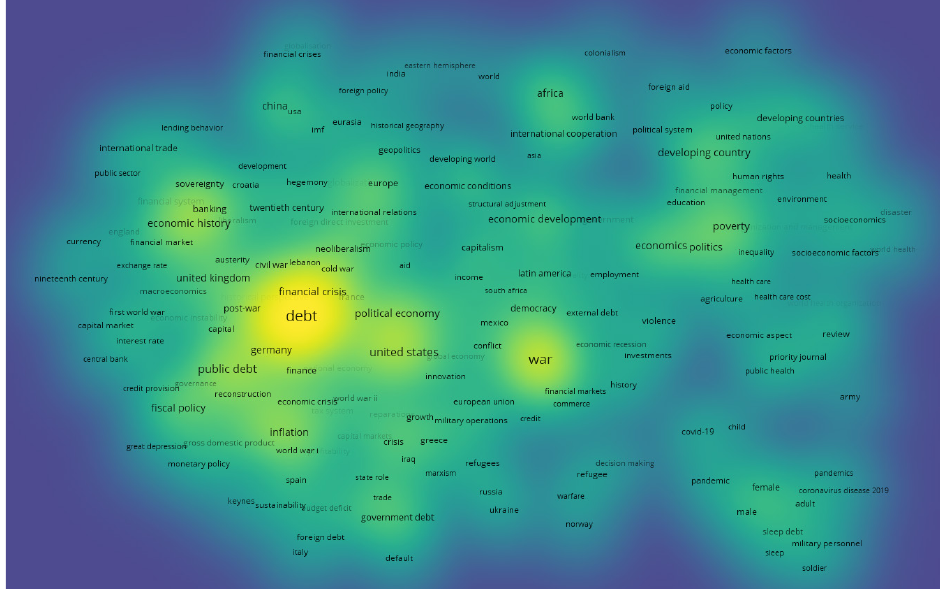
Figure 5. Map of connections between the concepts of public debt research based on publications in Scopus for